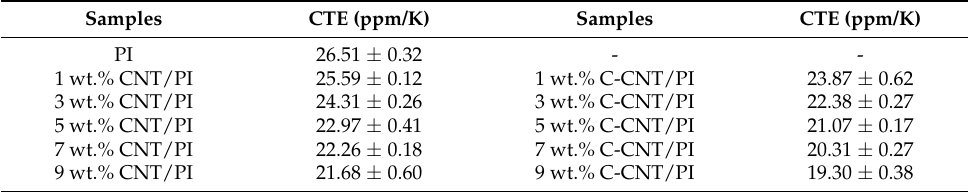
Table 6. The CTE values of PI, CNT/PI and C-CNT/PI films.